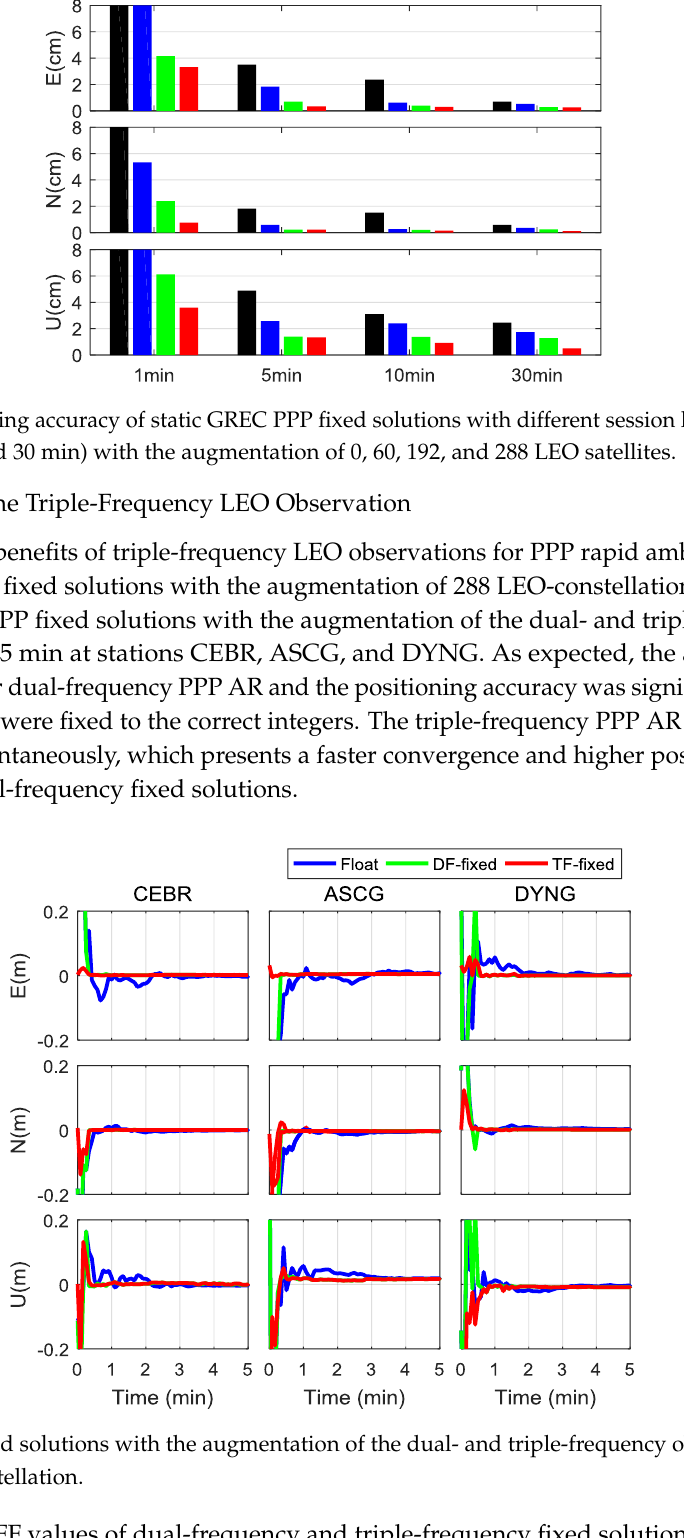
Figure 10. Average TTFF of the 288-LEO augmented GNSS PPP AR at dual-frequency and triple-frequency modes. 3.3. Multi-frequency LEO-only PPP AR To verify the capability of LEO constellation for precise positioning independently, we conducted the LEO-only PPP test in dual-frequency and triple-frequency modes based on the observation of 288-LEO constellation. Figure 11 shows LEO-only PPP float and fixed solutions at stations CEBR, AREG, and DYNG from 20:00 to 20:05 on January 1, 2017. According to Figure 11, the LEO-only PPP can converge to a centimeter level in all three components within 5 min and the ambiguity resolution can be achieved in a very short period, which is about 2 min. Compared to the dual-frequency LEO-only fixed solutions, the triple-frequency PPP fixed solutions present a better performance in terms of convergence and reliability.